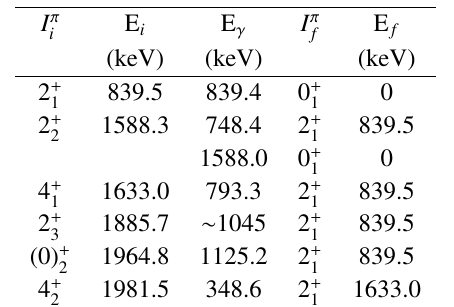
Table 5. Observed transitions in 130 Te. Level energies, spins and parities taken from Ref. [29].